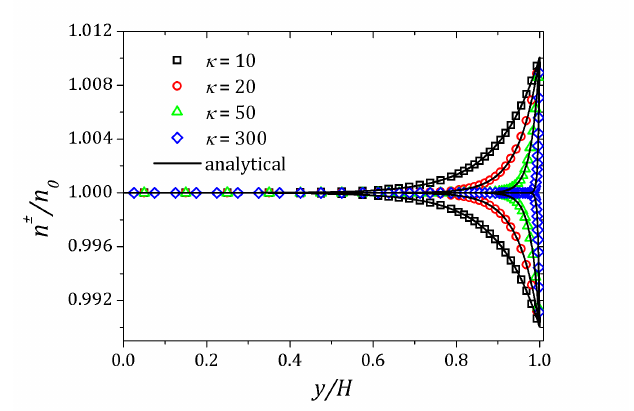
Figure 7. Ionic concentration n ± for different values of the Debye parameter. Results for κ = 10,20,50,300.